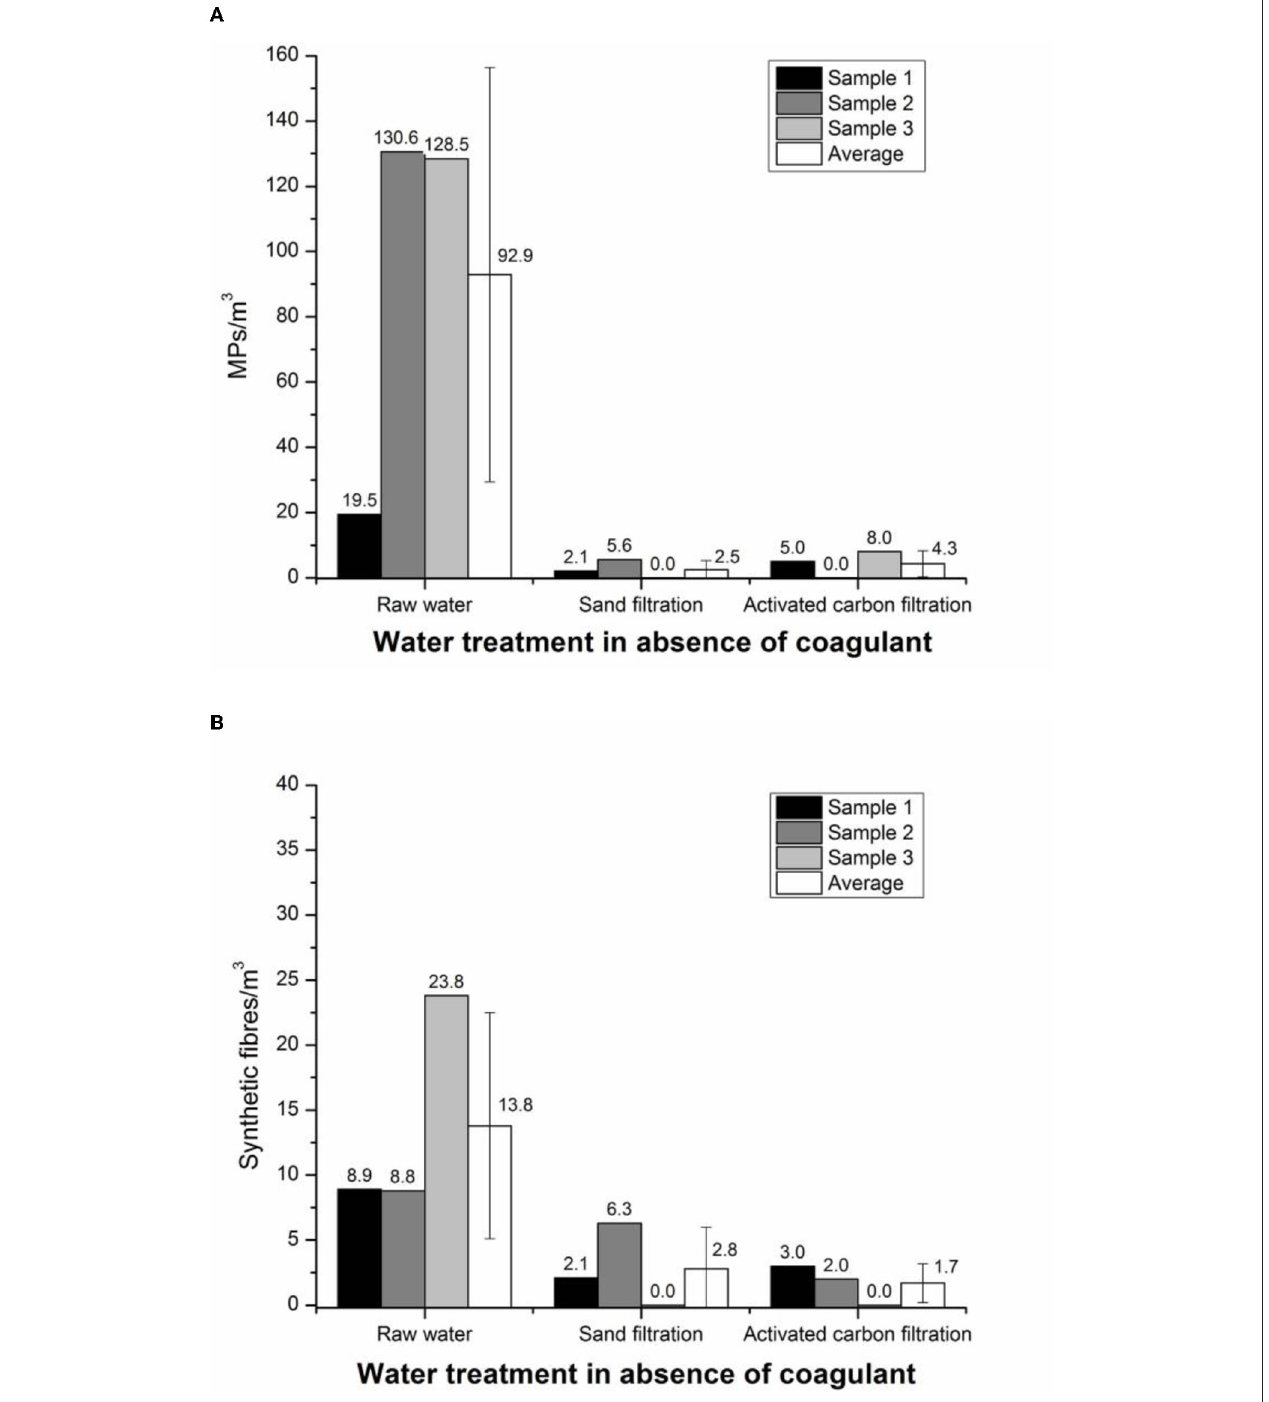
FIGURE 3 | Concentration of MPs (A) and synthetic fibres (B) in raw water, after sand filtration and after activated carbon filtration in absence of coagulant of each sampling and average with standard deviation. Contrary to MPs, synthetic fibres were mostly identified in size In presence of coagulant ( Figure 4B ), synthetic fibres were class ≥ 250 µ m both in the presence and absence of coagulant found significantly removed after sand filtration. No synthetic ( Figures 4B , 5B ). In the case of raw water, the percentage fibres were identified in drinking water in sizes < 250 µ m, but of synthetic fibres in the smallest size class was around 55%. synthetic fibres ≥ 250 µ m were still persistent although in low